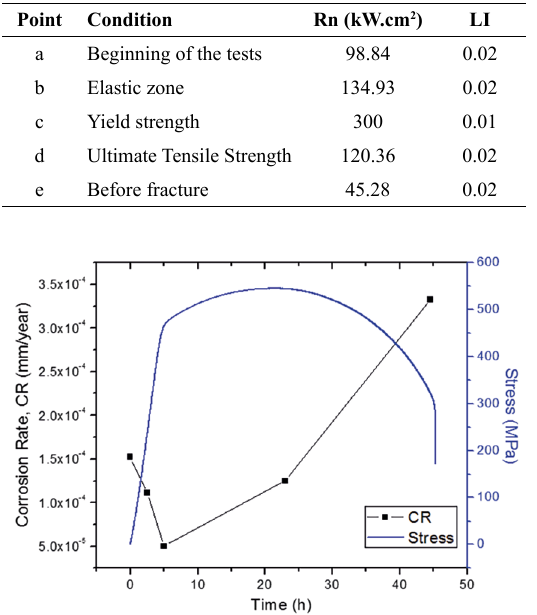
Table 6. Statistical parameters obtained from